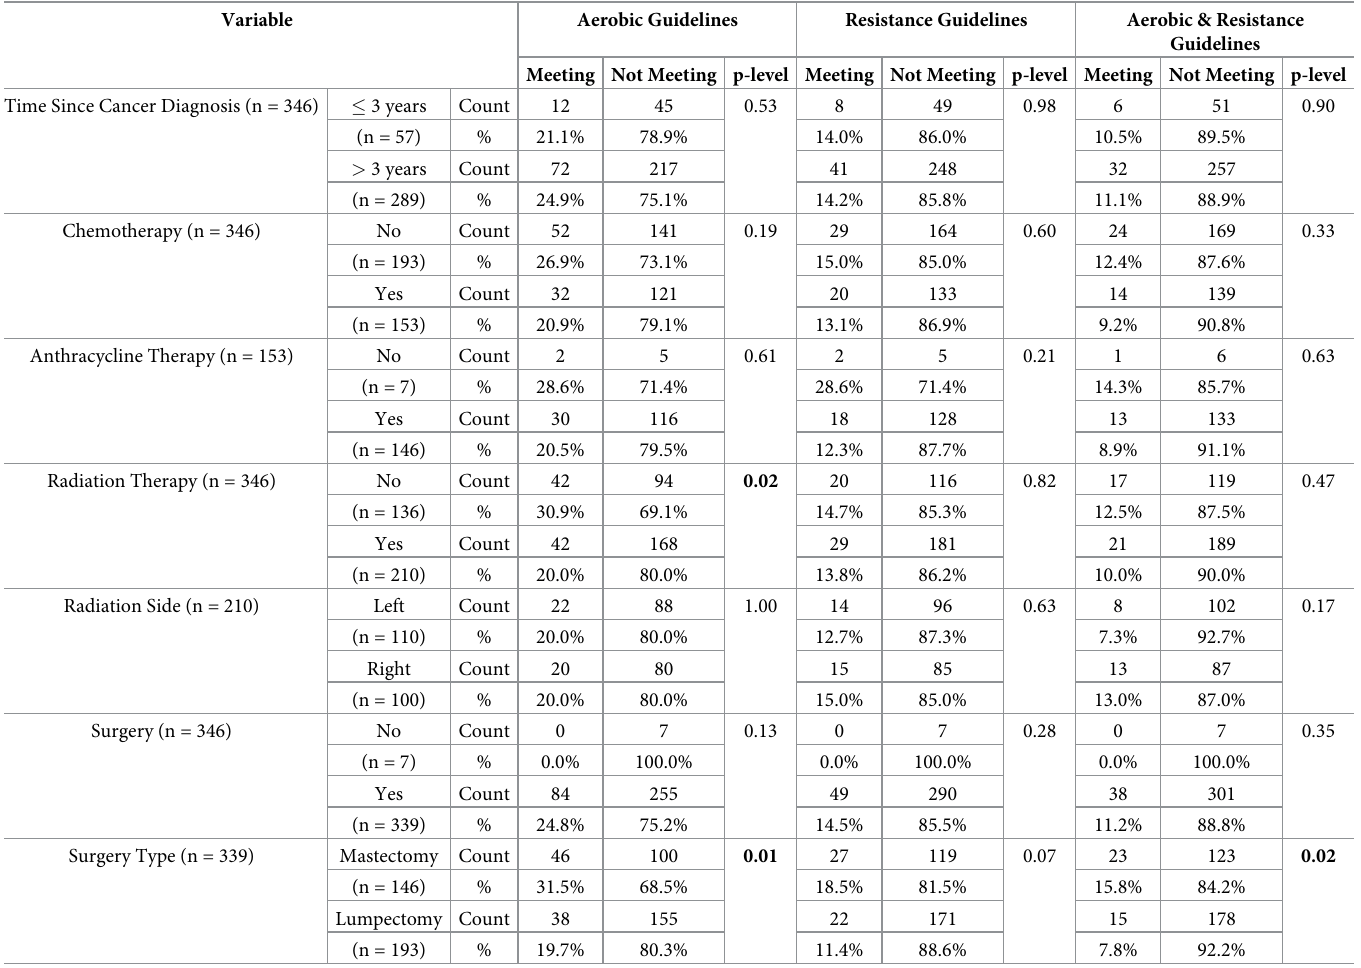
Table 2. Adherence to physical activity guidelines by treatment exposure among female breast cancer